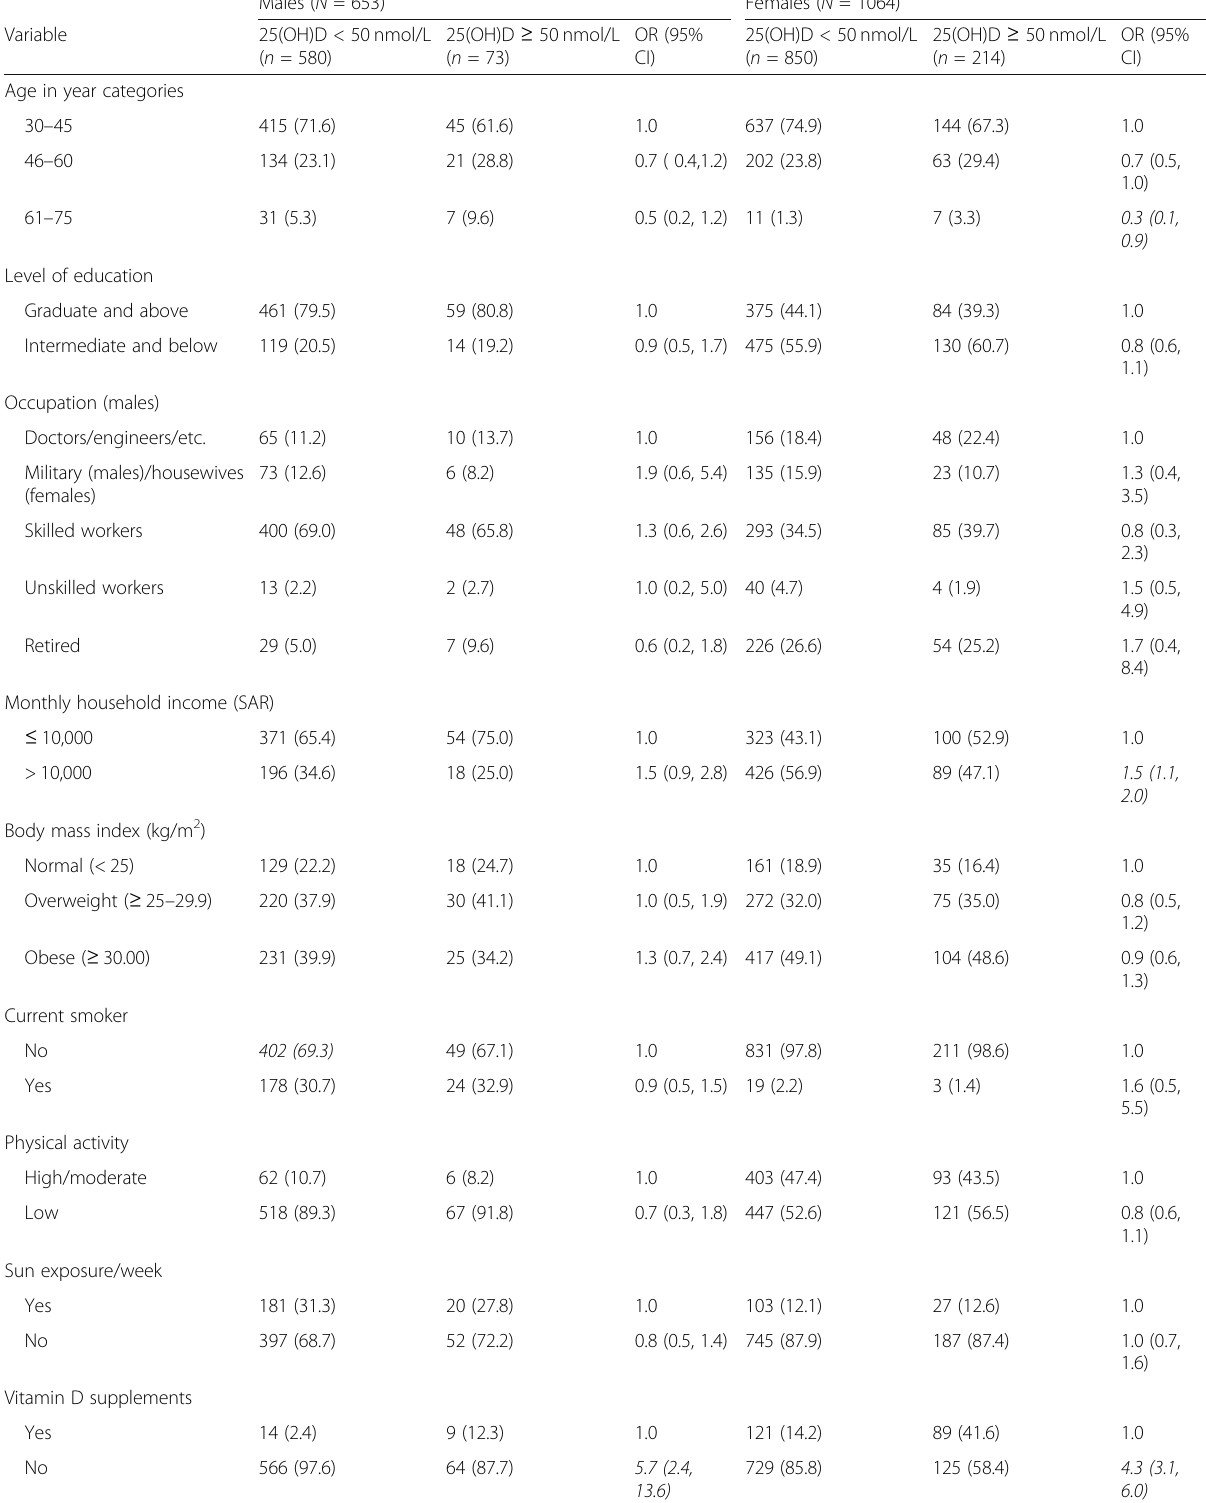
Table 2 Bivariate analysis showing unadjusted odds ratio and 95% CI between socio-demographic and lifestyle factors with low vitamin D in Saudi male and female participants in Riyadh, Saudi